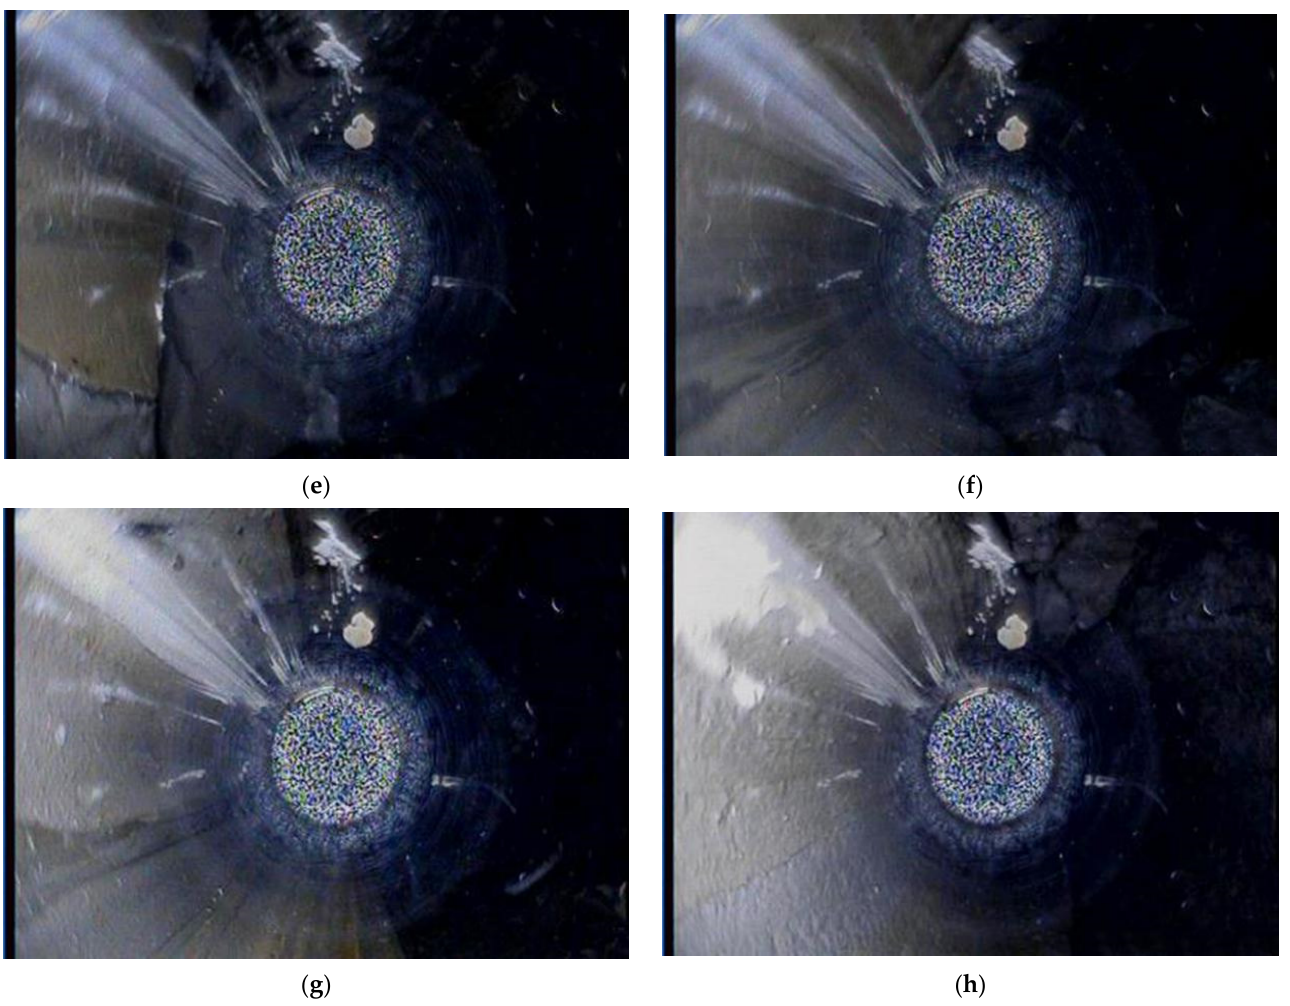
Figure 5. Photos of overburden fractures at different positions in the No. 3 post-mining borehole. ( a ) Vertical depth 8.43 m. ( b ) Vertical depth 16.09 m. ( c ) Vertical depth 25.33 m. ( d ) Vertical depth 29.20 m. ( e ) Vertical depth 42.70 m. ( f ) Vertical depth 45.54 m. ( g ) Vertical depth 46.4 m. ( h ) Vertical depth 52.99 m. Note: for the No. 3 post-mining borehole, the bottom right corner of the photo shows the borehole depth.